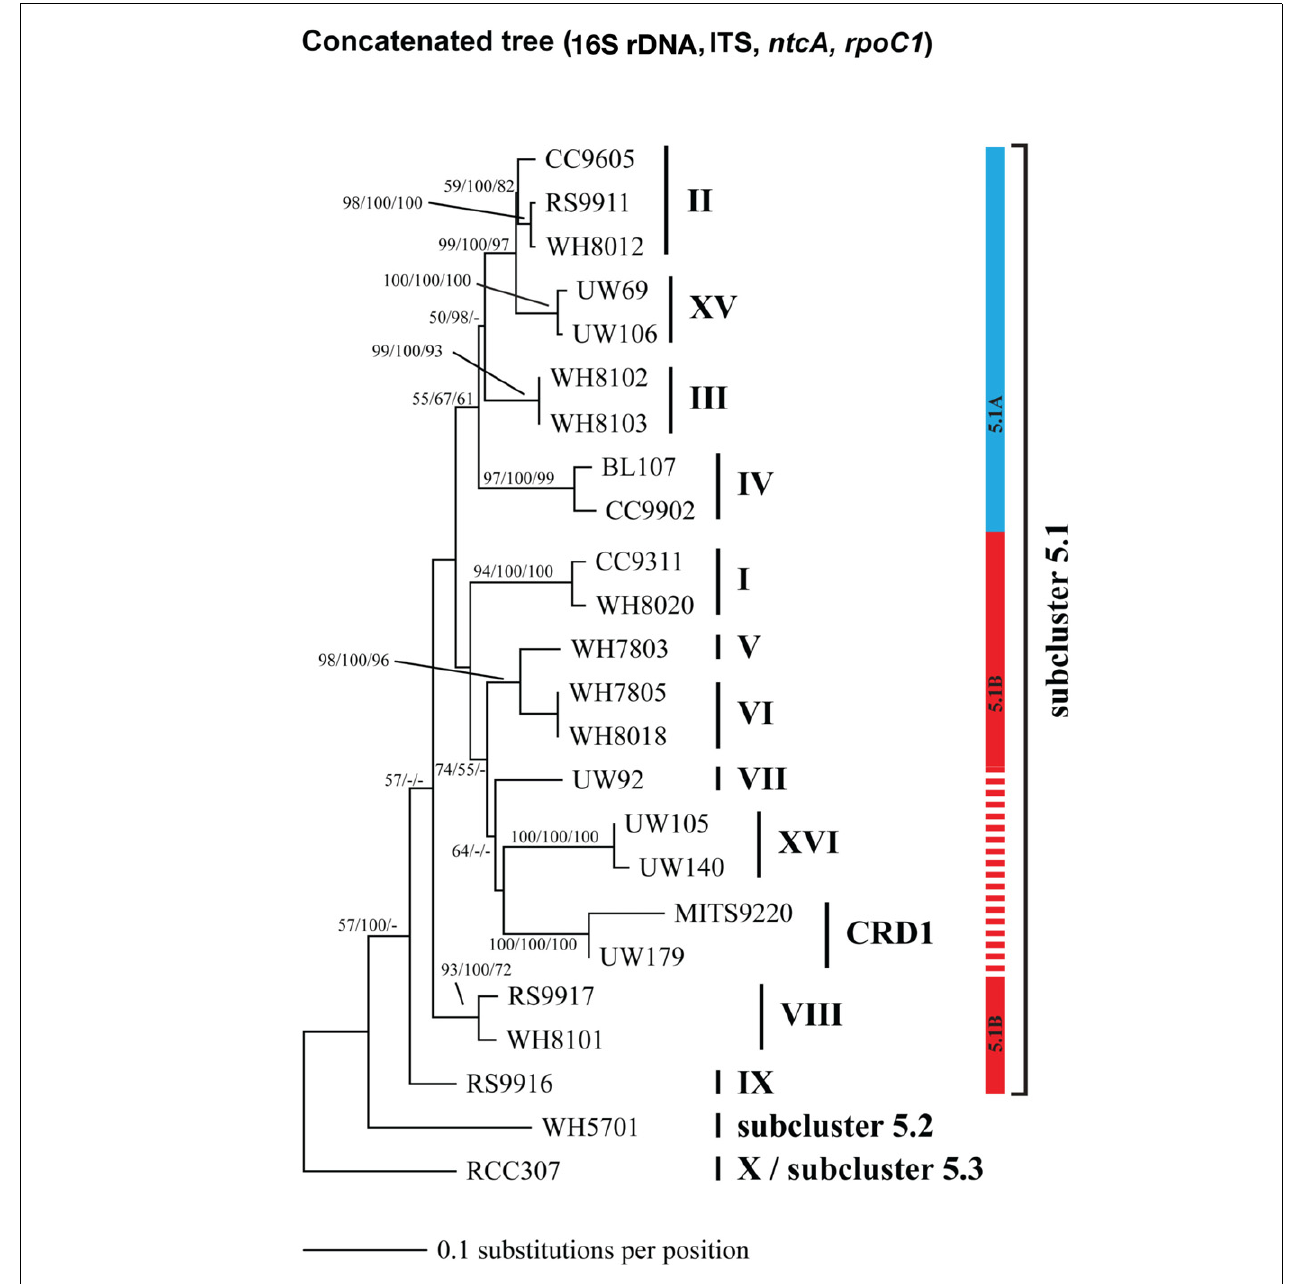
genomes support the division of strains subcluster 5.1 into two groups 5.1A (blue bar) and 5.1B (solid red bar) (Dufresne et al., 2008).The four loci concatenated phylogeny in FigureA6 also supports the grouping of 5.1A strains, including clade XV. Strains in cladesVII, CRD1, and XVI cluster with other 5.1B strains in cladesV andVI with high bootstrap support, however it is unclear if these additional new strains without sequenced genomes form a single monophyletic cluster with all 5.1B strains (dashed red